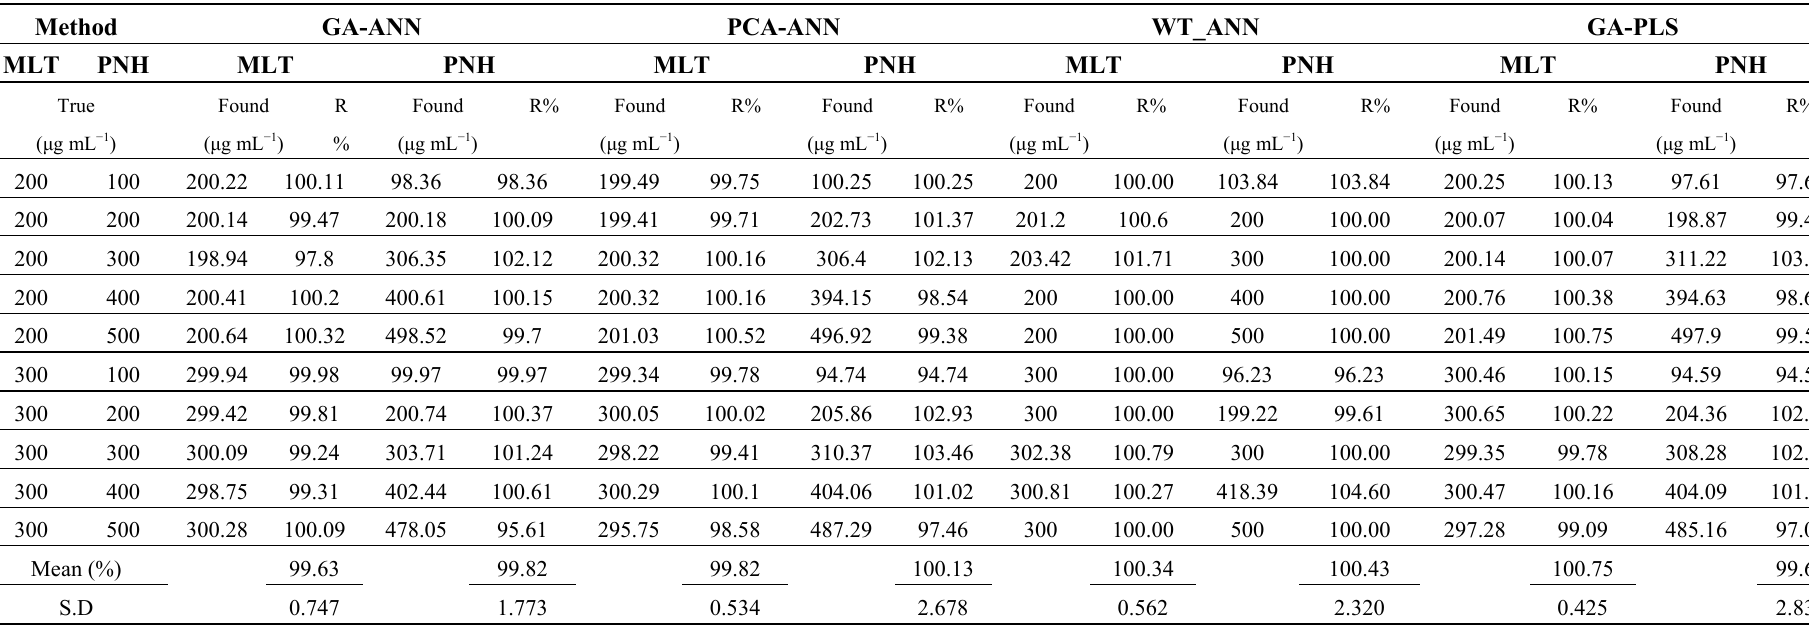
Table 7. Analysis results for the prediction of MLT and PNH in the validation set by the proposed multivariate calibration